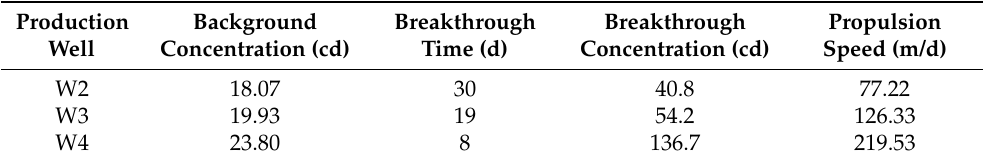
Table 4. The tracer test results of A well